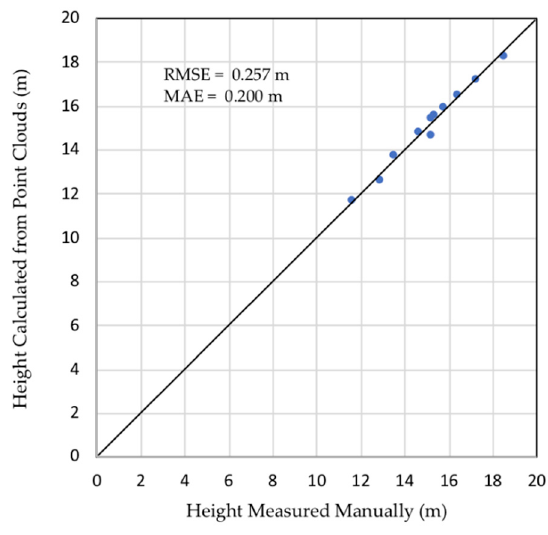
Figure 19. Comparison of manually-measured and calculated heights.